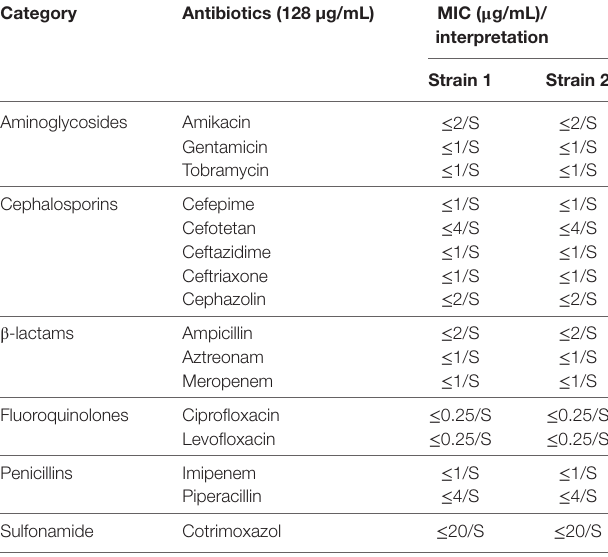
TaBle 3 | Antibiotic susceptibility testing of atypical EPEC isolates.